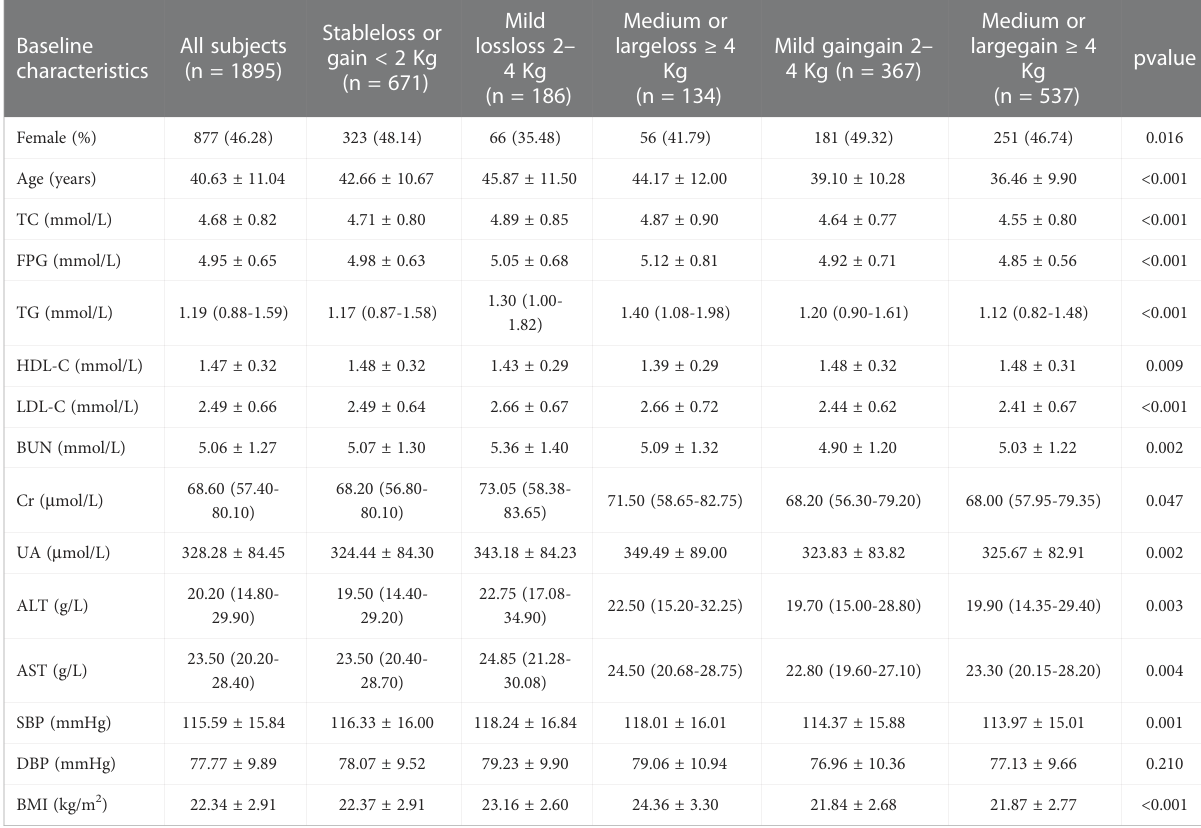
TABLE 1 Baseline characteristics of study participants by body weight